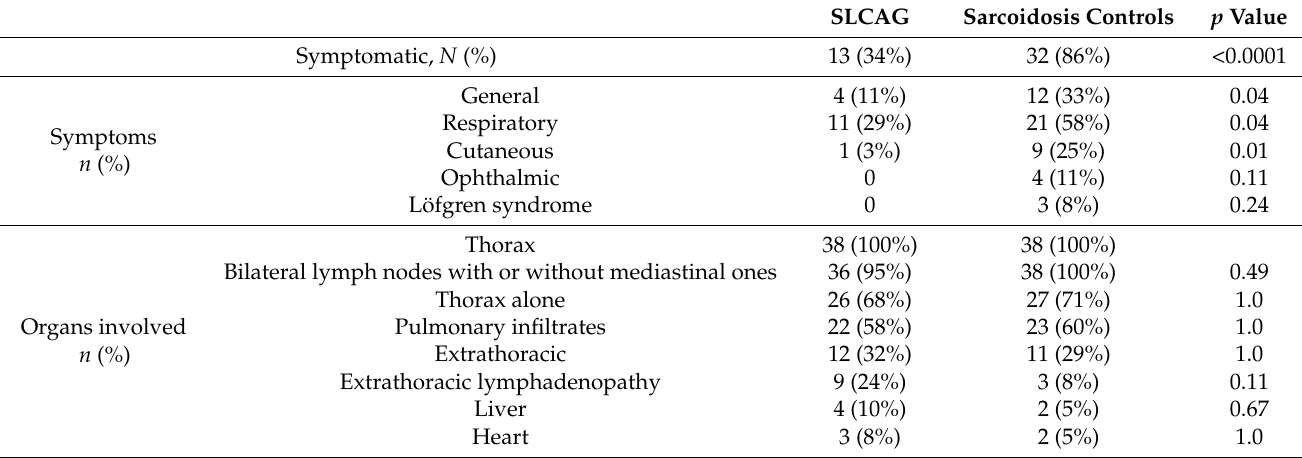
Table 2. Baseline clinical characteristics of SLCAG and sarcoid